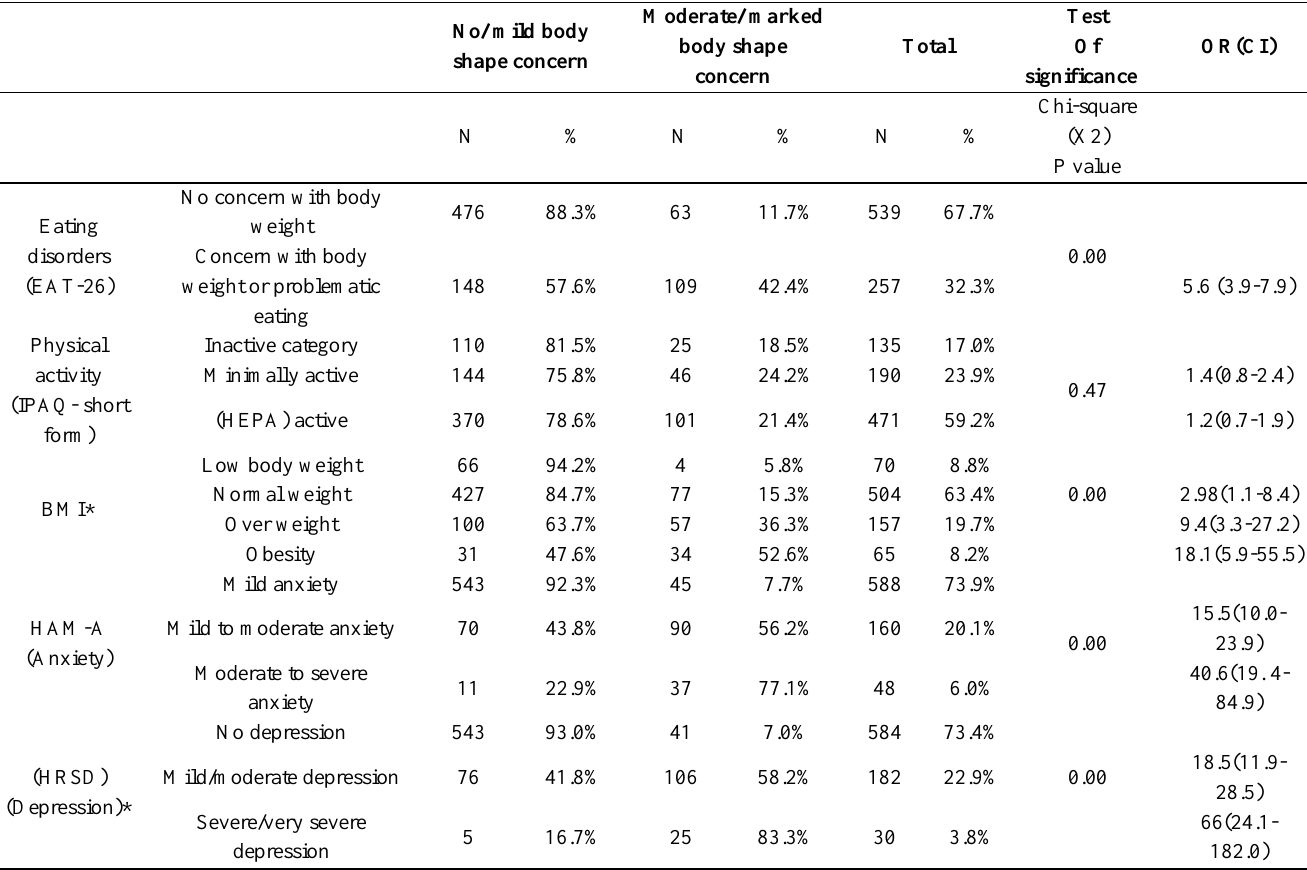
Table 2: Clinical characteristics scales of the studied group (N=796) by their body shape concern measured by Body shape questionnaire (BSQ- 34) (2015-2017).